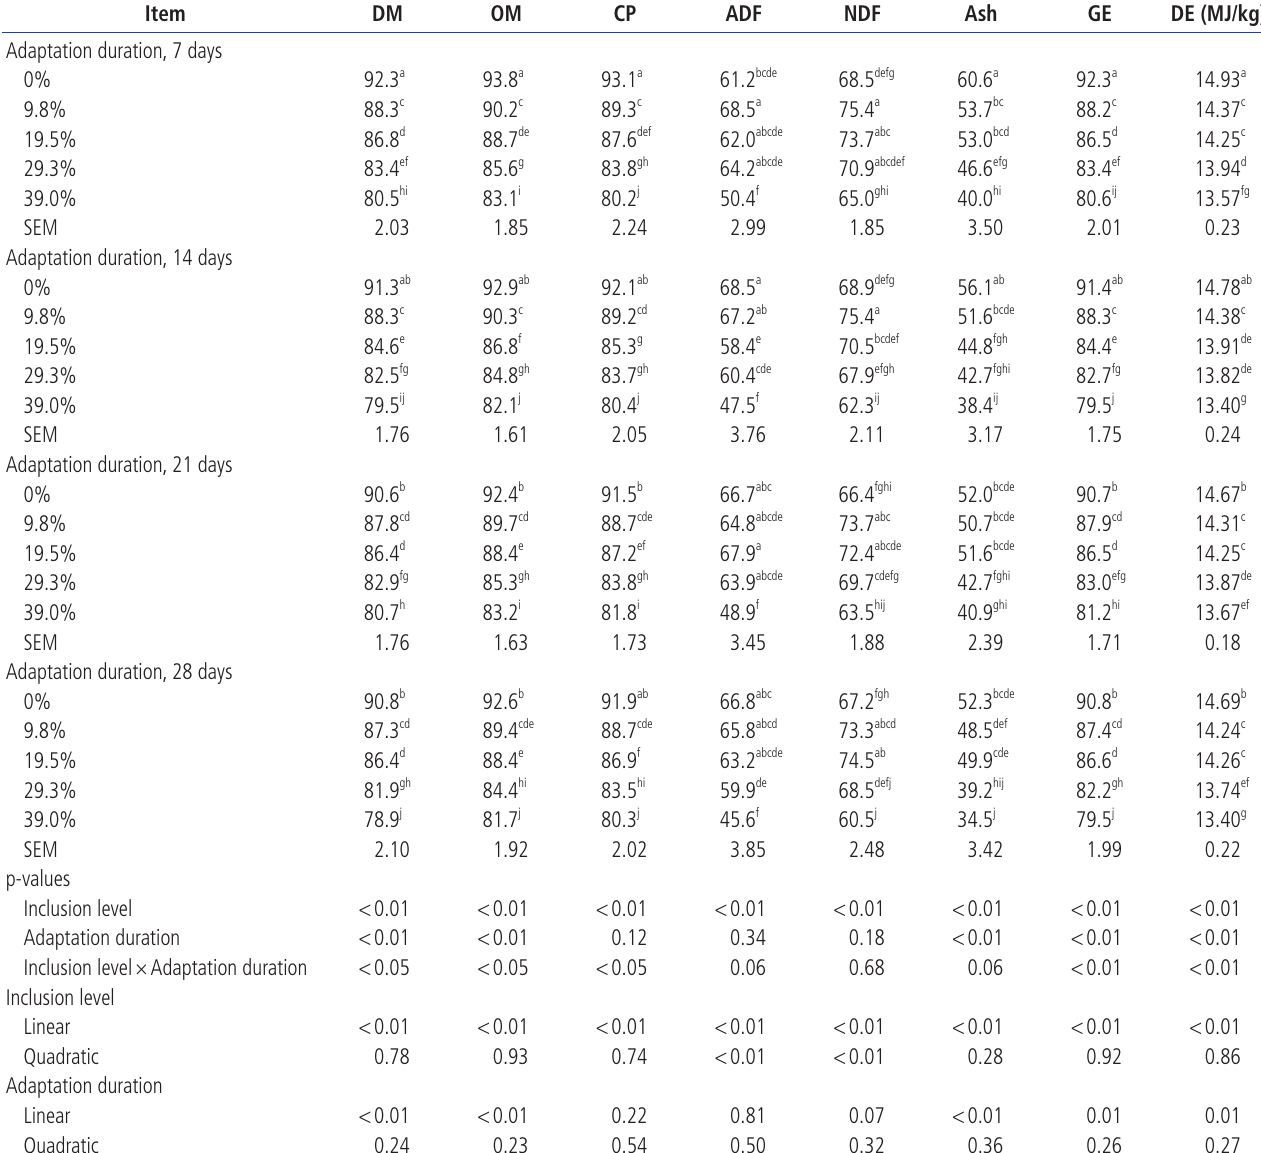
Table 3. Effect of inclusion levels of palm kernel meal and the adaptation duration on the digestible energy (DE, as fed-basis) content and the apparent total tract digestibility (ATTD, %) of chemical composition in diets fed to growing-finishing pigs